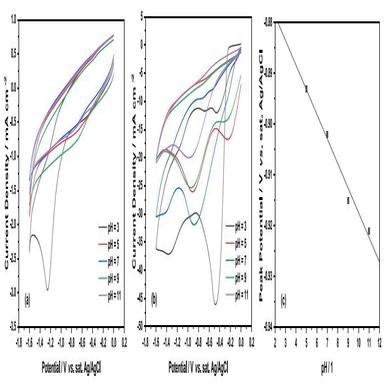
Cyclic voltammetry of GCE in solutions of different pH. (a) CV curve in blank electrolyte with the absence of H2O2 in different pH on GCE; (b) CV curve in the electrolyte with 0.2 mol L− 1 H2O2 in different pH on GCE; (c) the relationship between the peak potential of the CV curve of GCE in H2O2 electrolytes and the pH of the electrolyte.